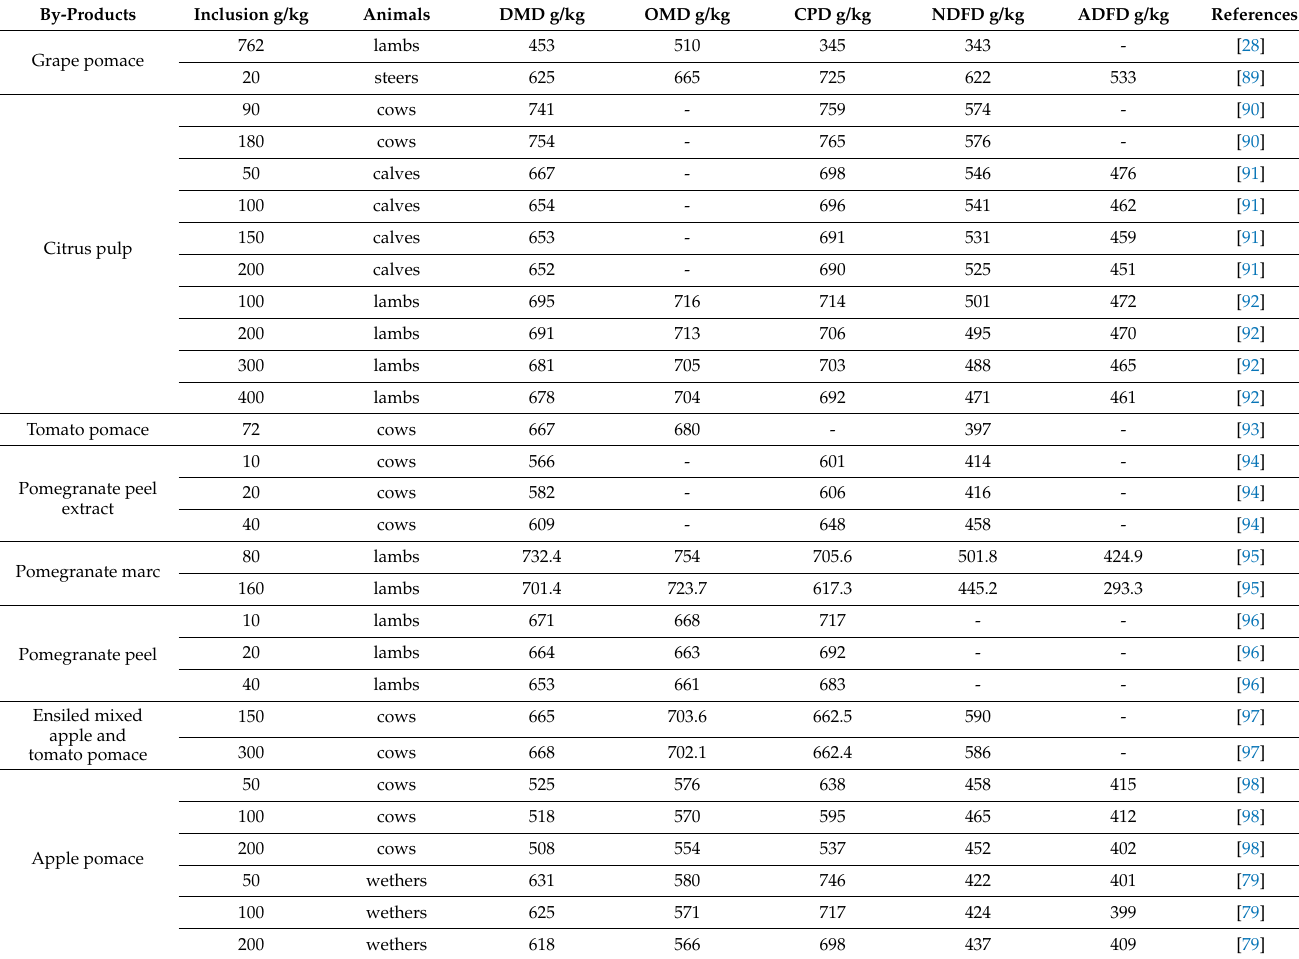
Table 3. Effects of FVBPs on the nutrient digestibility of